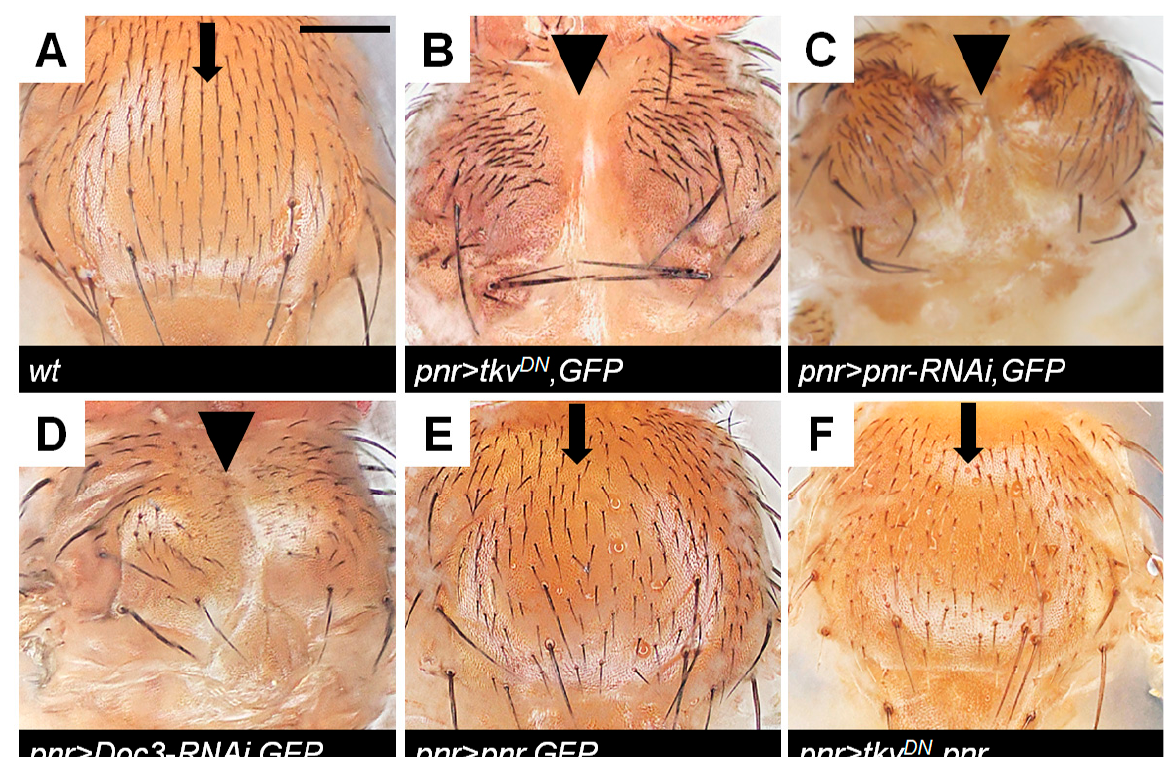
Figure 3. Doc is required for correct thorax closure. ( A ) Wild type adult notum. Arrow indicates the midline. ( B ) A medial cleft (arrowhead) develops at 100% frequency, indicating severe thorax closure defects, when Dpp signaling is inhibited by tkv DN over-expression. ( C ) Inhibition of pnr results in thorax closure defect with complete penetrance. ( D ) A mild thorax closure defect is also caused by Doc3 knock-down. ( E ) Expression of pnr alone in the notum region does not induce thorax closure defects. ( F ) Expression of pnr rescues the thorax closure defect caused by tkv DN . The black arrows indicate the success of thorax closure. The black triangles indicate the failure of thorax closure. Scale bar, 200 µ